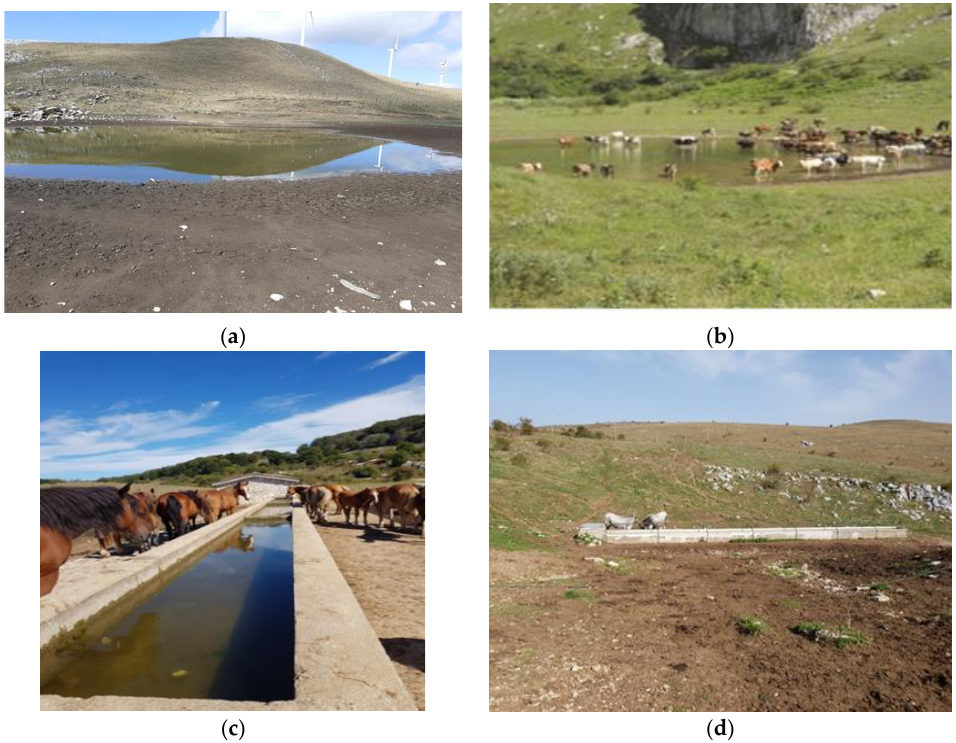
Figure 3. Examples of water pools and stone drinking troughs used by herds sampled in this study. ( a )